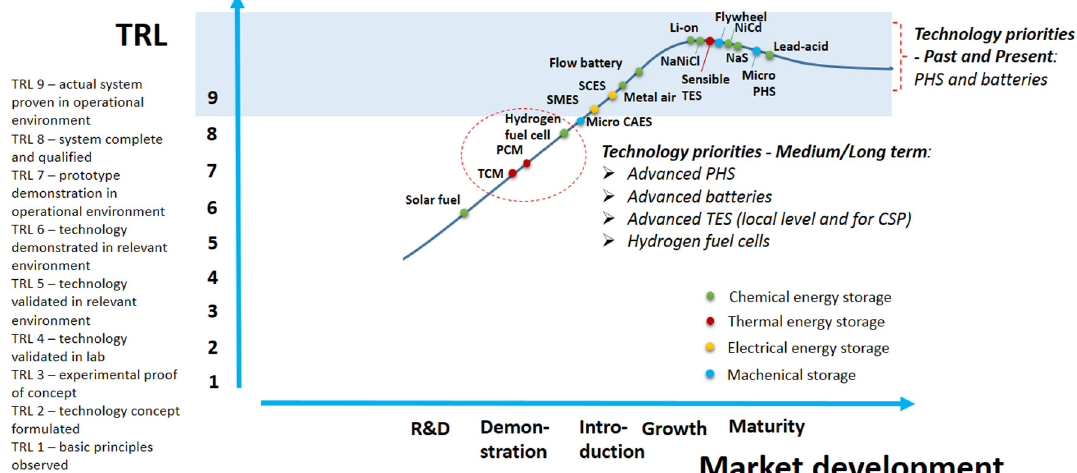
Fig. 1. Technology maturity curve of energy storage technologies for small scale energy systems. Data extracted and analysed from [2 –